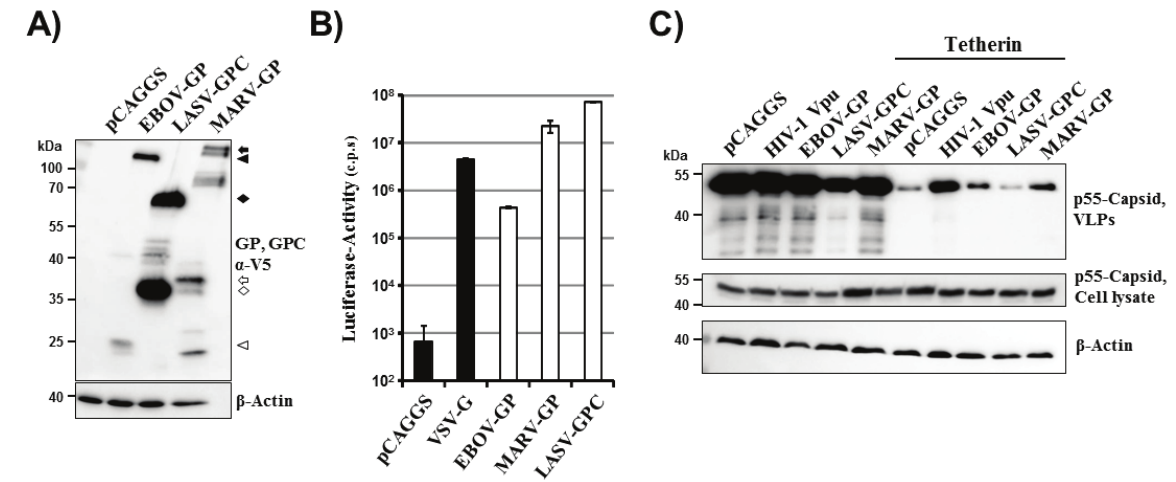
Figure 1. Filovirus but not Lassa virus glycoproteins counteract tetherin. ( A ) Plasmids encoding the indicated glycoproteins with a C-terminal V5 tag were transfected in 293T cells and GP expression was analyzed by Western blot employing a V5-specific